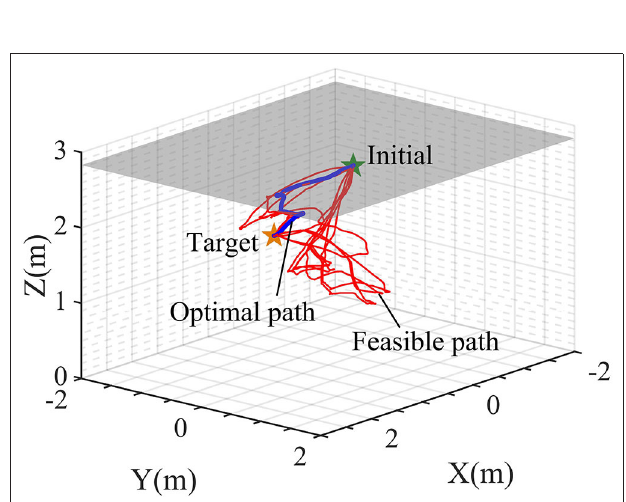
FIGURE 5 | Motion path of the center of the upper